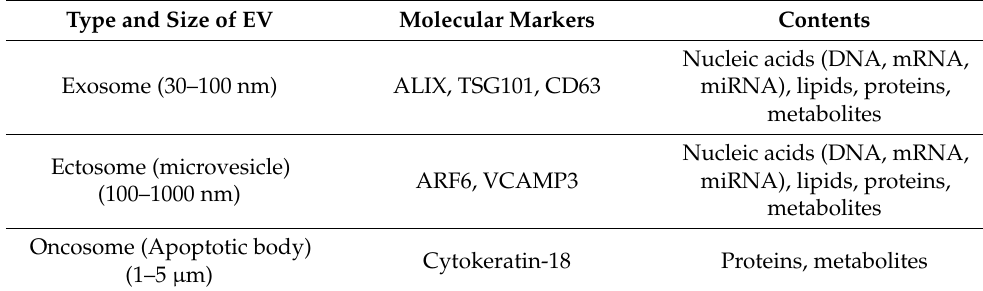
Table 1. Characteristics of extracellular